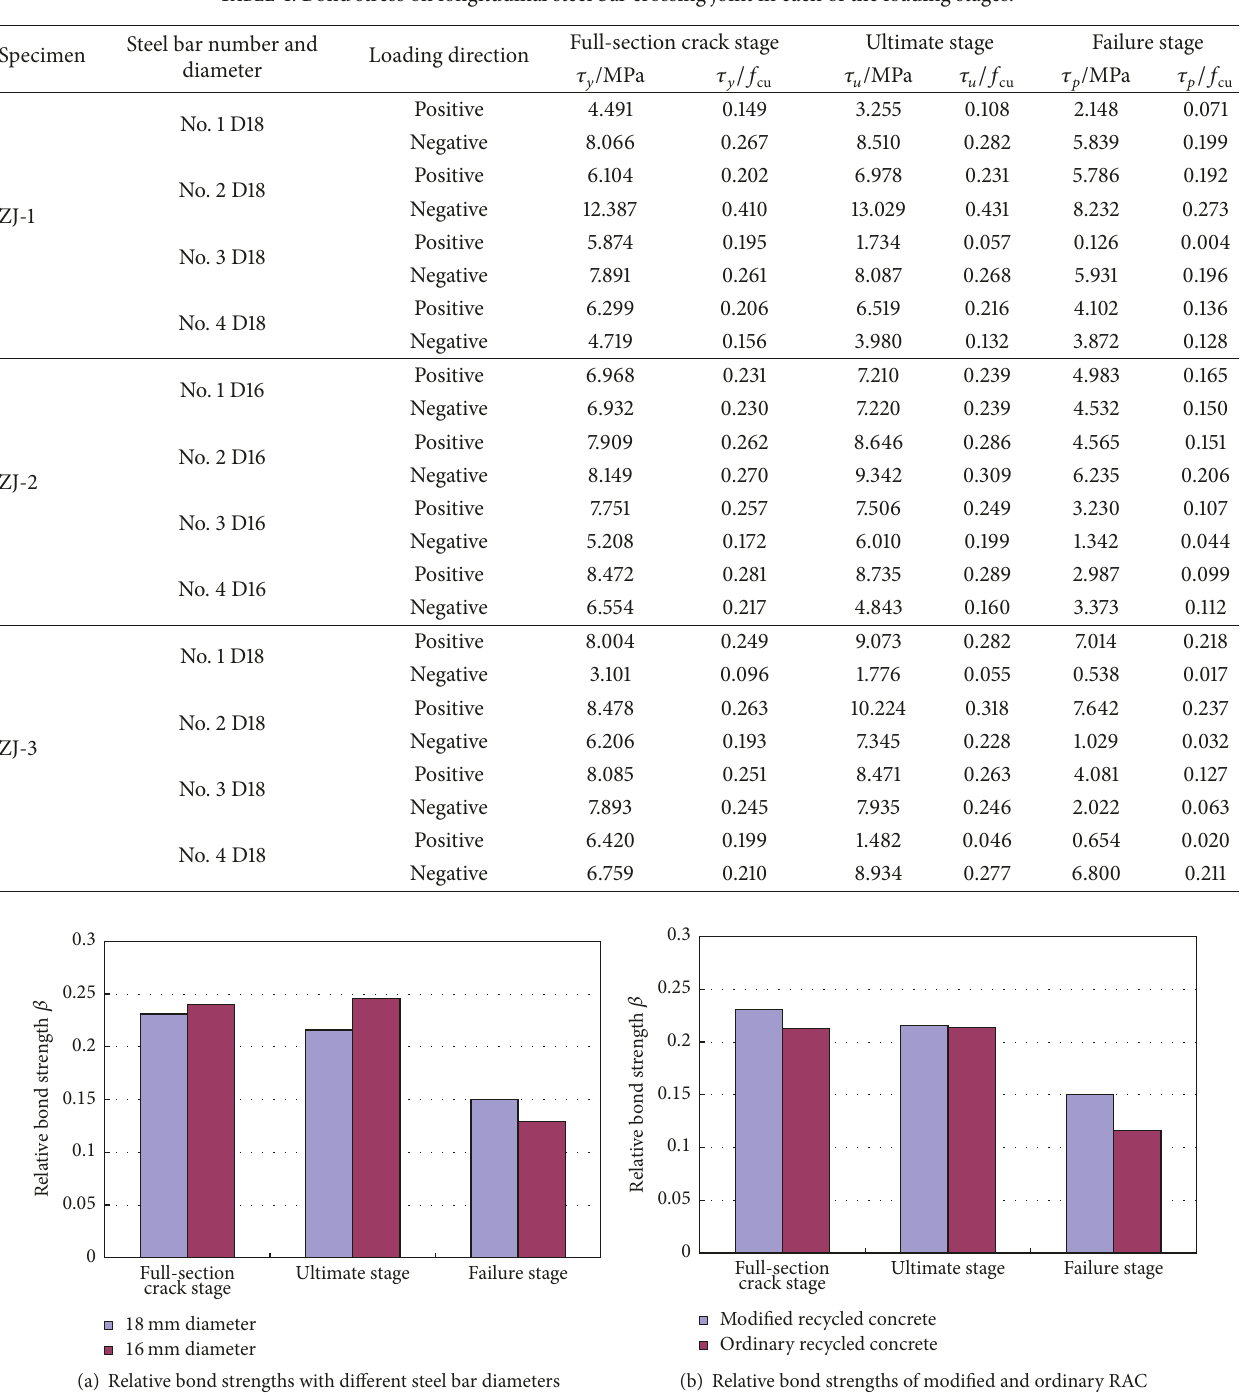
Figure 11: Relative bond stresses of longitudinal steel